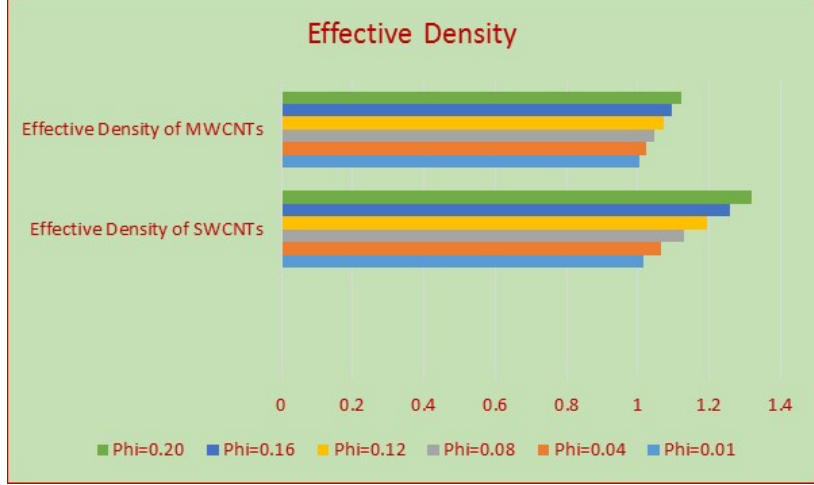
Figure 10. The behavior of density of SWCNTs and MWCNTs for multiple volume fraction factor ϕ .